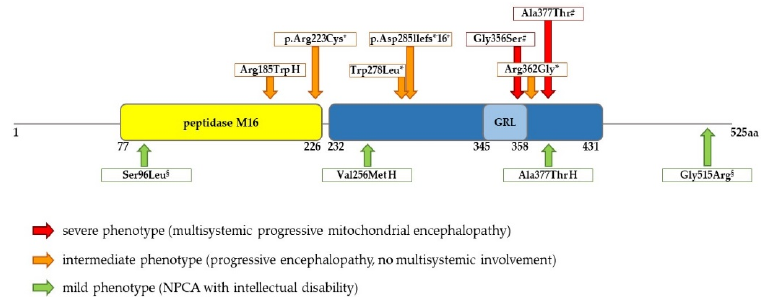
Figure 3. Established peptidase mitochondrial processing alpha (PMPCA) domain structure and location of missense mutations previously reported. Mutations identified in homozygous state are indicated with H, while heterozygous mutations identified together in a compound heterozygous state are equally marked (*, #, § or + ). For each mutation, severity of related phenotype is indicated with a color code.